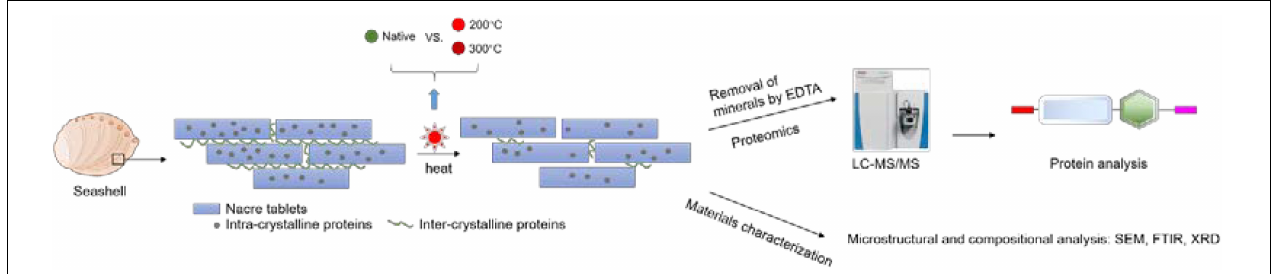
FIGURE 1 | The experimental process of toasting abalone shells. Shells were heated at 200 and 300 ◦ C for 10 min and native shells as the control. Then the shells were decalcified by EDTA and the remaining proteins were analyzed by LC-MS/MS. Additionally, the microstructure and composition of shells were examined by SEM, FTIR, and XRD.